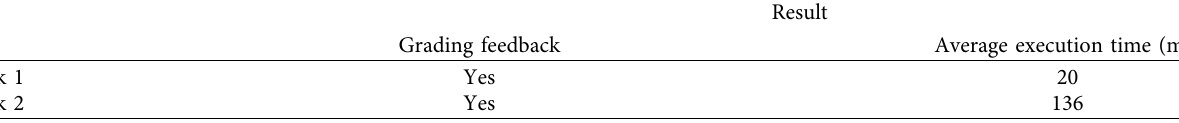
Table 5: Dynamic grading result.